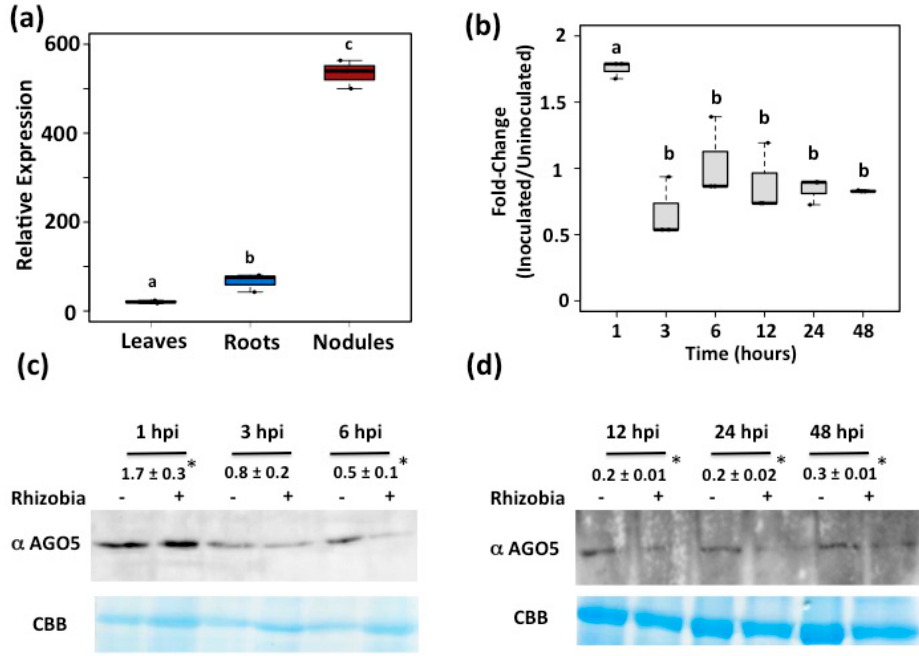
Figure 5. AGO5 is preferentially expressed in soybean roots and nodules. ( a ) Expression pattern of GmAGO5 in leaves, roots and nodules from three weeks old soybean plants; ( b ) Expression profile of GmAGO5 in rhizobia-inoculated root from two days old soybean plants. Box plots represent first and third quartile (horizontal box sides), minimum and maximum (outside whiskers). Data shown was obtained from four independent biological replicates. One-way ANOVA followed by a Tukey HSD test was performed ( p -value < 0.01). Statistical classes sharing a letter are not significantly different; ( c , d ) AGO5 protein expression in rhizobia-inoculated roots from two days old soybean plants. Immunoblot shown is a representative figure from three biological replicates. The intensity of the bands was quantified densitometrically, and the inoculated/uninoculated expression ratios were obtained for each time point. Values are mean and standard error of three biological replicates. Asterisks indicate a significant difference according to Student’s t -test ( p -value < 0.01). hpi = hours post-infection.